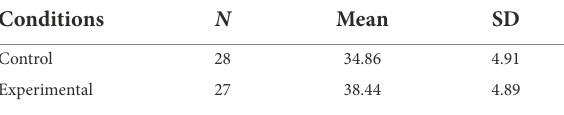
TABLE 5 Independent samples t-test between conditions (control and experimental) post-test.